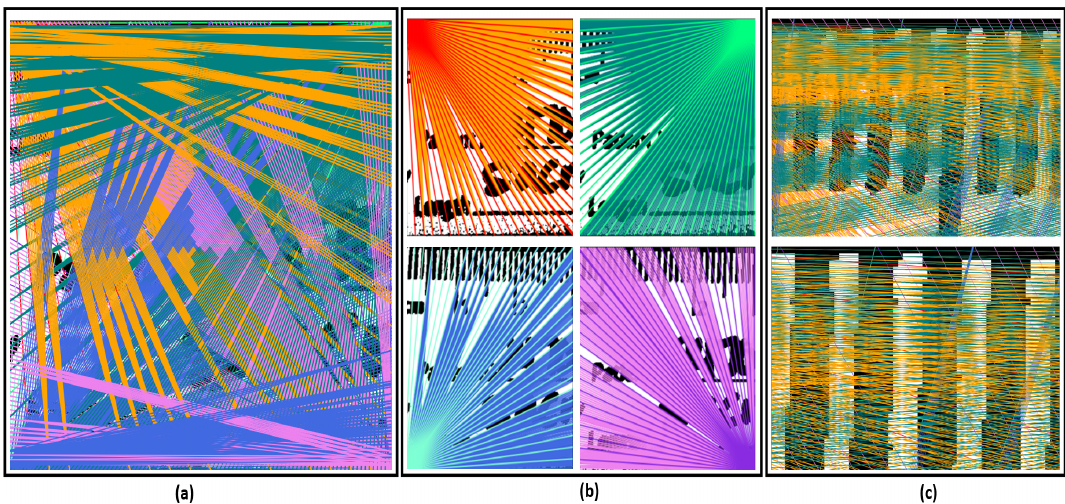
Figure 3. (Deep Search Rendering) ( a ) All searches collectively. Note the crisscrossing at the top of the image where the density shows the search optimization. ( b ) Each search separated by the corner where the search started. In the top left, the red lines correspond to the initial search. ( c ) A zoomed in piece of each search where a set of ticks are located (best seen in color).